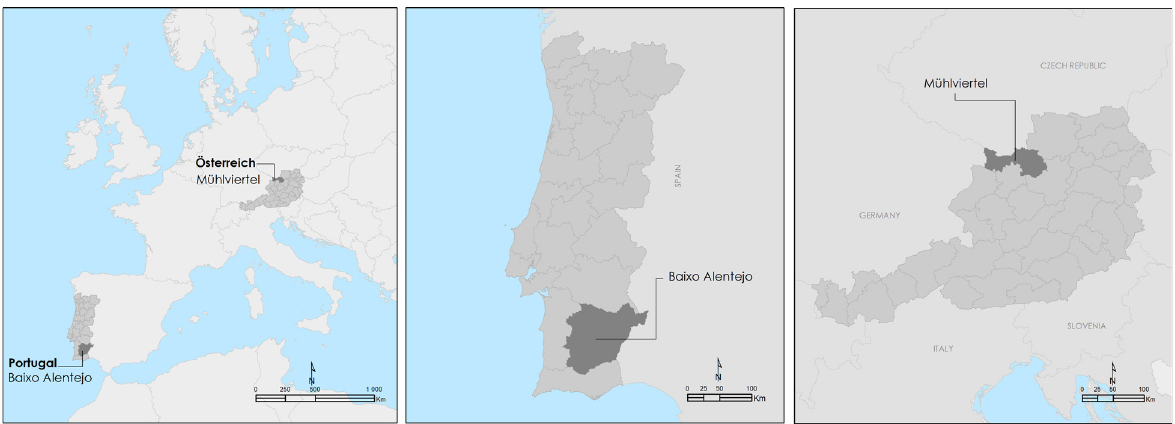
Fig. 1. Map with the location of two regions under study. Source: own elaboration based on Eurostat